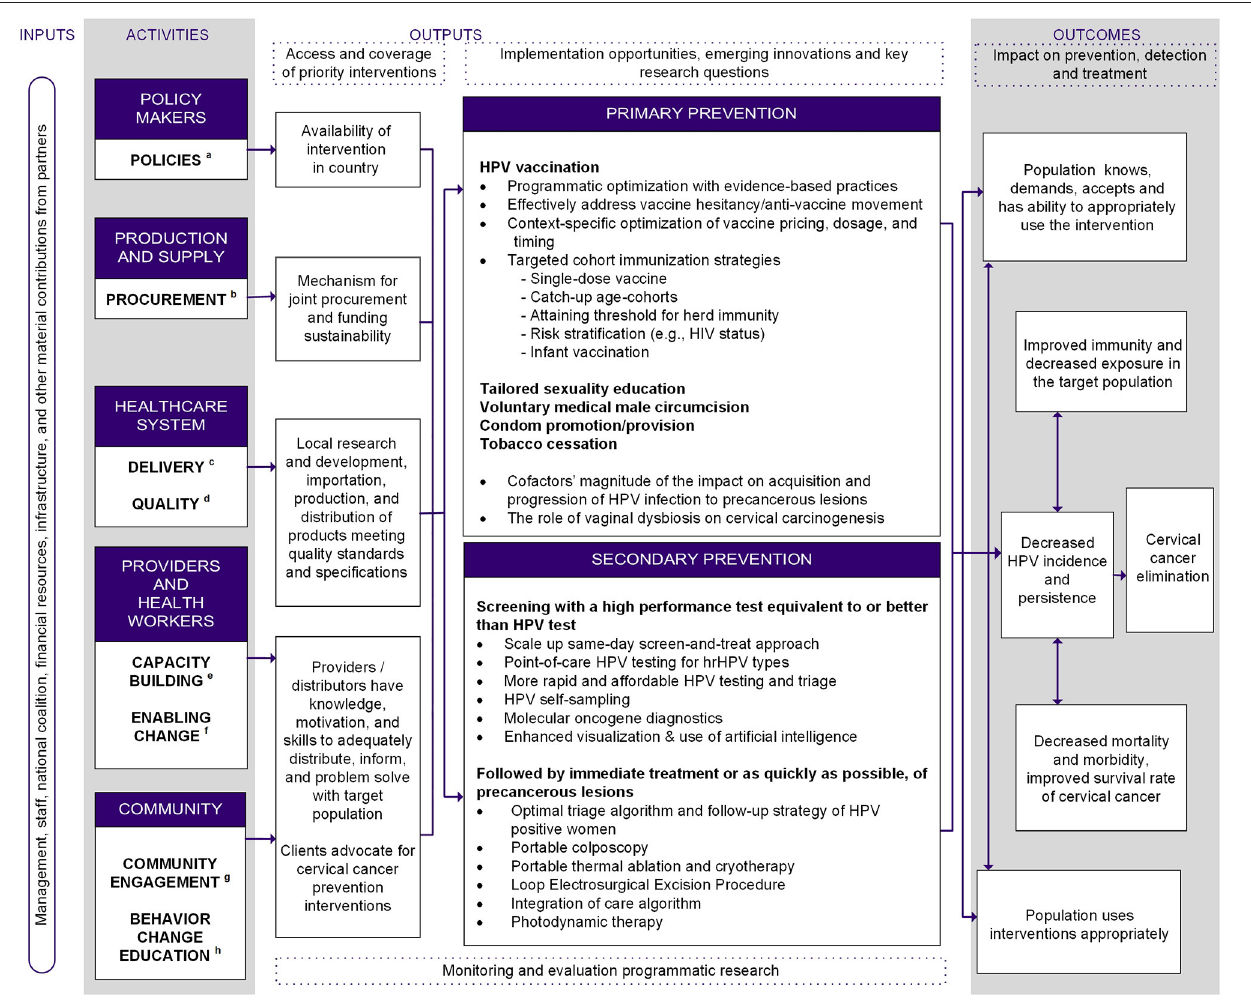
FIGURE 1 | Logic model for comprehensive, intersectoral cervical cancer prevention. a Policies: develop and implement policies, legislation regulations, and registrations. b Procurement: develop and implement provision, production, procurement and training strategies. c Delivery: develop and implement delivery system, strategy for management, training, and maintain motivation among providers and distributors. d Quality: develop and implement an external and internal quality control system. e Capacity building: develop provider and health worker skills training, infrastructure and capacity building. f Enabling change: cultivate dialogue to promote adoption of innovative technologies and approaches (e.g., task-shifting/sharing) to simplify care delivery and break conflicts of interest. g Community engagement: demand promotion by empowering local stakeholders and advocacy. h Behavior change education: develop and implement intervention strategy for information, education, and communication for behavior